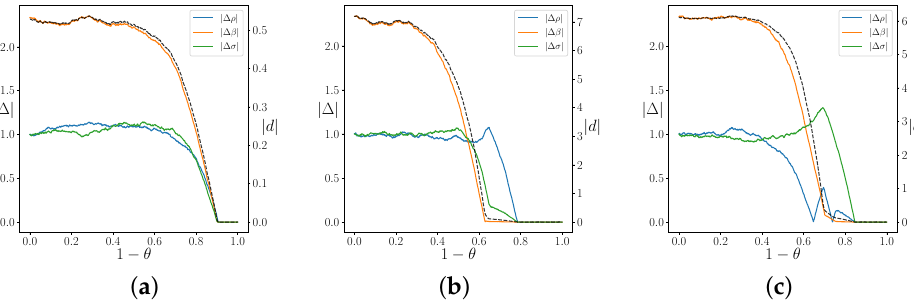
Figure 5. The state–variable distance d (dashed line) and parameter distance (color) as a function of p c and different coupling directions C . ( a ) C = [ 1,1,1 ] ; ( b ) C = [ 1,0,0 ] ; temperature θ for p = 0.6 (cid:29) ( c ) C = [ 0,1,0 ] . We set θ = 1, (cid:101) = 10 − 4 , T =